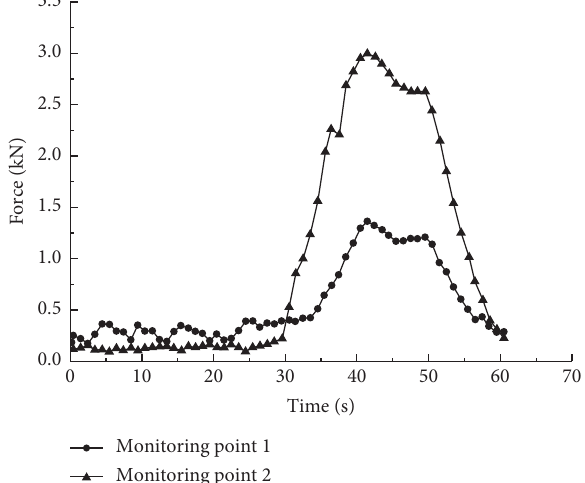
Figure 7: The two local load time-history curves in the same experiment.